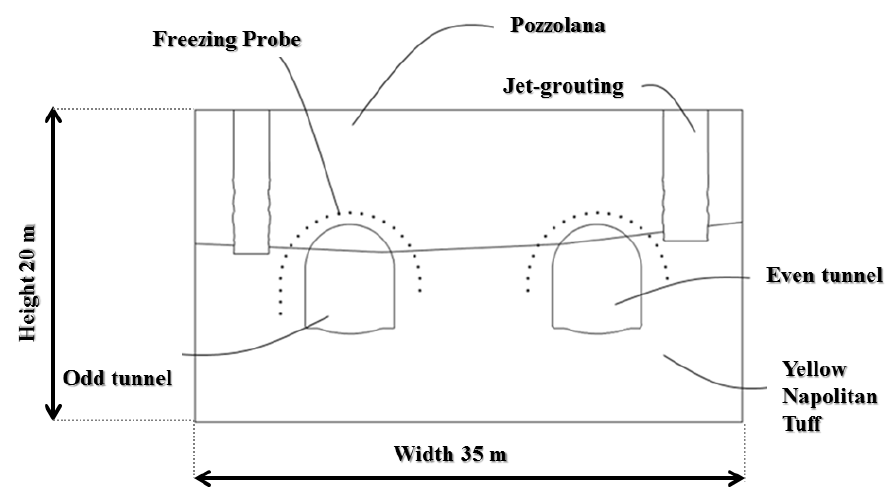
Figure 6. Sketch of the computational domain with the two tunnels considered in the numerical analysis.